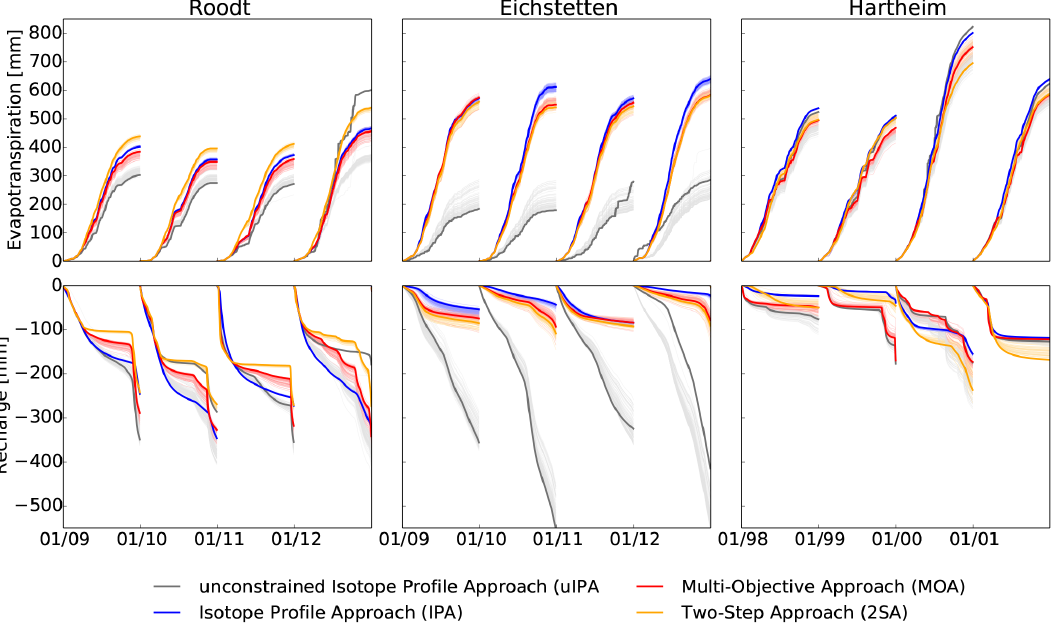
Figure 5. Annual simulated cumulative actual evapotranspiration (first row) and cumulative recharge through the − 200cm (Roodt and Eichstetten) and − 120cm (Hartheim) depth planes (lower row). Solid lines show simulations with the parameter sets that performed best during the different inverse modelling approaches at each study site and the thin transparent lines represent simulations with 100 randomly chosen parameter combinations of the set S best .